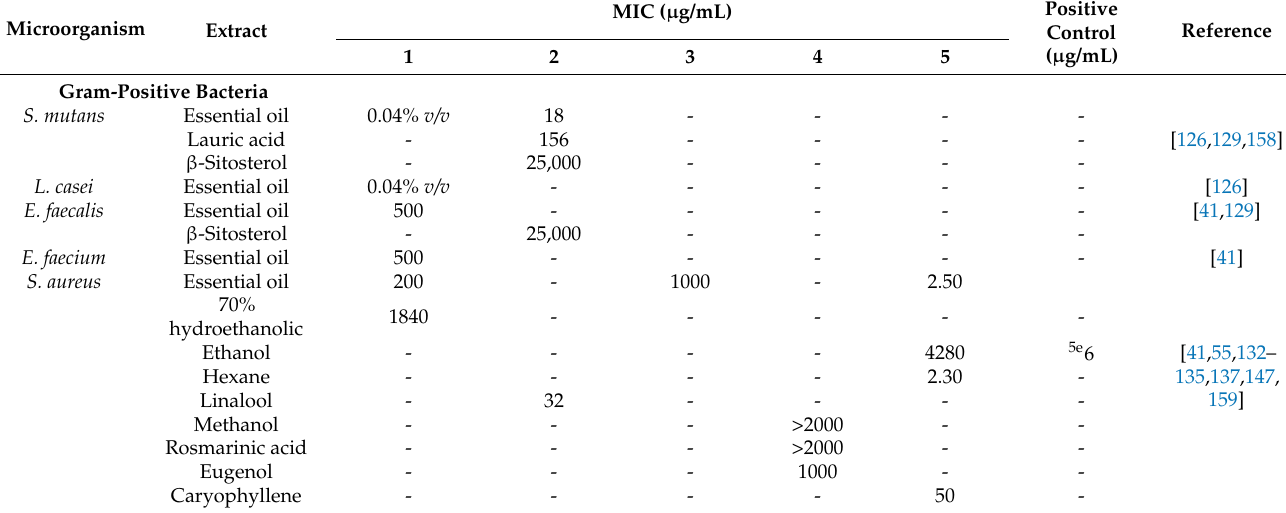
Table 7. Data of minimum inhibitory concentration (MIC) of Ocimum